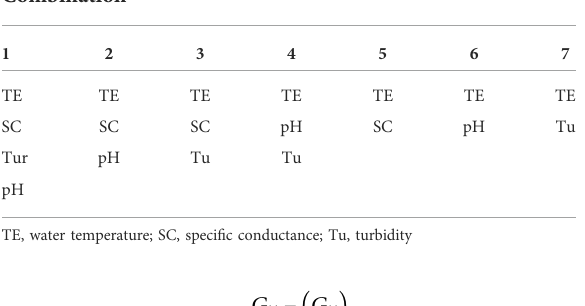
TABLE 2 Selected input combinations for DO prediction at study stations.